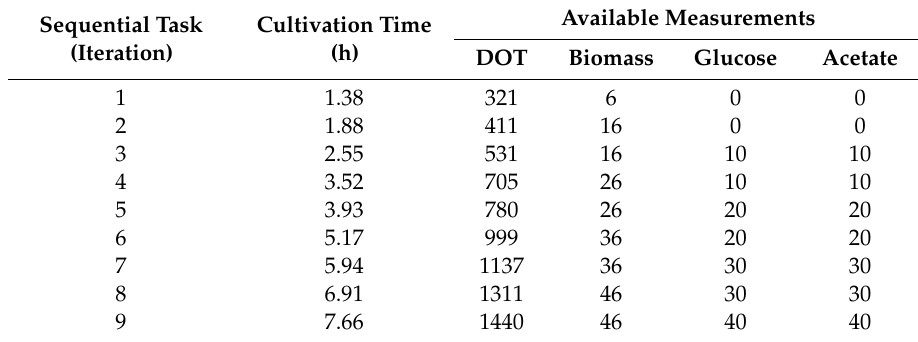
Table 1. Underlying data sets, i.e., the number of sensor data, for the parameter estimates of one biological triplicate. DOT—dissolved oxygen